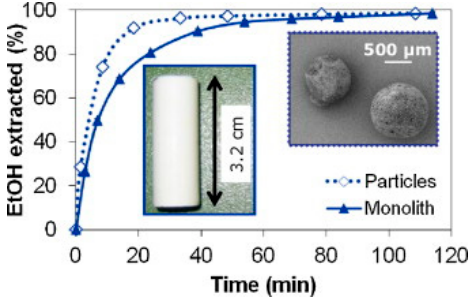
Figure 19. Comparison of supercritical drying profiles of starch aerogel particles and monoliths. Adopted with permission from [32]. Picture on the left: monolith, picture on the right: particles.